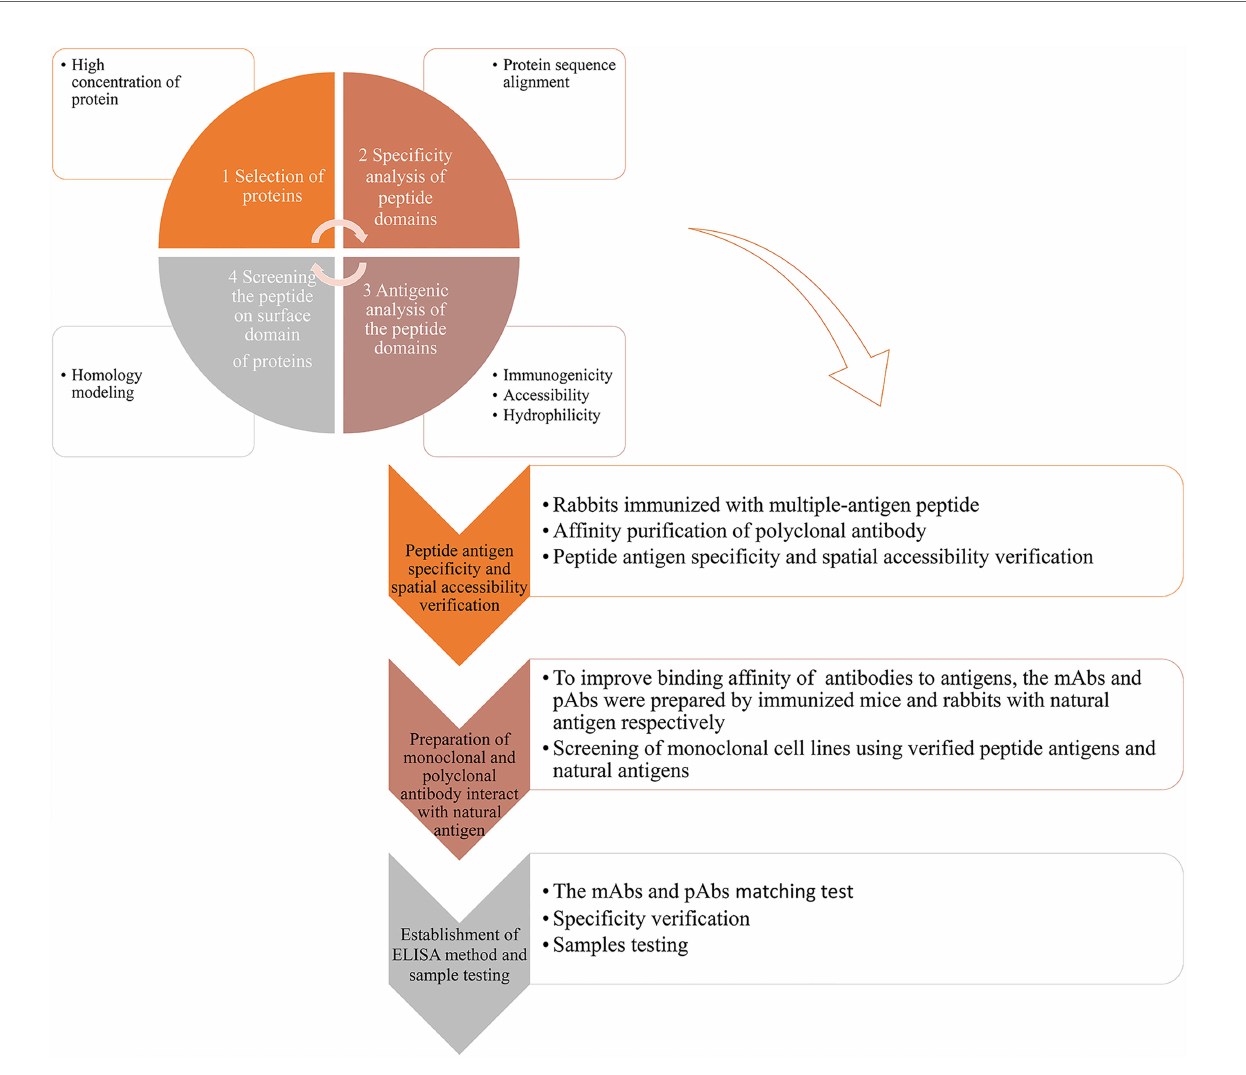
FIGURE 1 | Graphical abstract of the antibody development strategy. 1) Based on data mining and analysis of snake genomes, transcriptomes, and proteomes, highly abundant proteins of representing species of a genus were selected. Speci fi c peptides of the representing species were identi fi ed by BLAST analysis. Using the Protean module in Lasergene, the antigenic properties of the protein were analyzed, and antigenicity of the speci fi c peptide was determined, including immunogenicity, accessibility, secondary structure, and hydrophilicity. Based on the protein structure or homology modeling results in SWISS-MODEL (online), the spatial position of speci fi c peptides in the protein was con fi rmed, and speci fi c peptides located on the surface of the protein were selected. 2) pAbs-p against peptide antigens were prepared by immunizing rabbits with KLH – peptide complex antigens. Antigen binding ability, antigen speci fi city, and accessibility of pAbs-p were veri fi ed. 3) Natural protein antigens containing peptide antigens were isolated and puri fi ed, and mAbs-n and pAbs-n against protein antigens were prepared. Binding ability and speci fi city of mAbs-n and pAbs-n were detected. 4) mAbs-n and pAbs-n were matched and veri fi ed by ELISA. Apparent concentrations of snake venom using simulated snakebites were